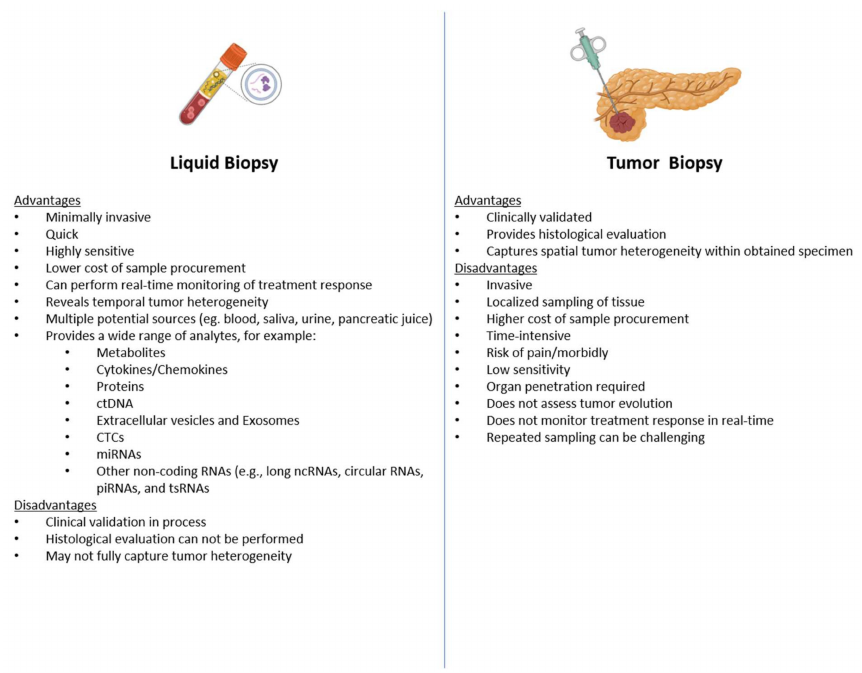
Figure 1. Liquid versus Tumor Biopsy. Abbreviations: DNA, deoxyribonucleic acid; PCR, polymerase chain reaction; ctDNA, circulating tumor DNA; CNA, copy number alterations; NGS, next generation sequencing; ddPCR, droplet digital PCR; RNA, ribonucleic acid; CTC, circulating tumor